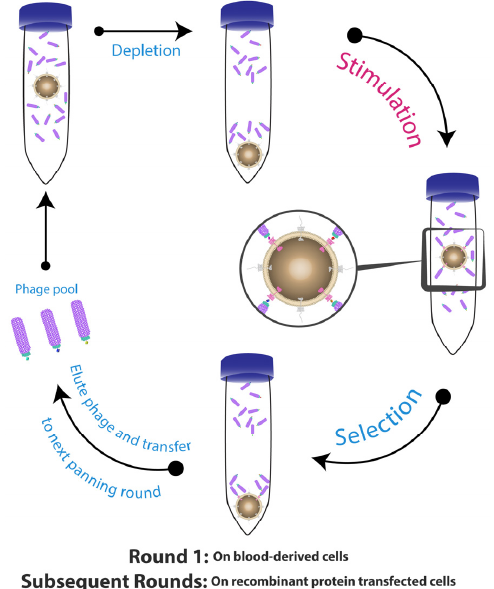
Figure 1. Selection of conformation-specific single-chain variable domain (scFv)-phage. The process